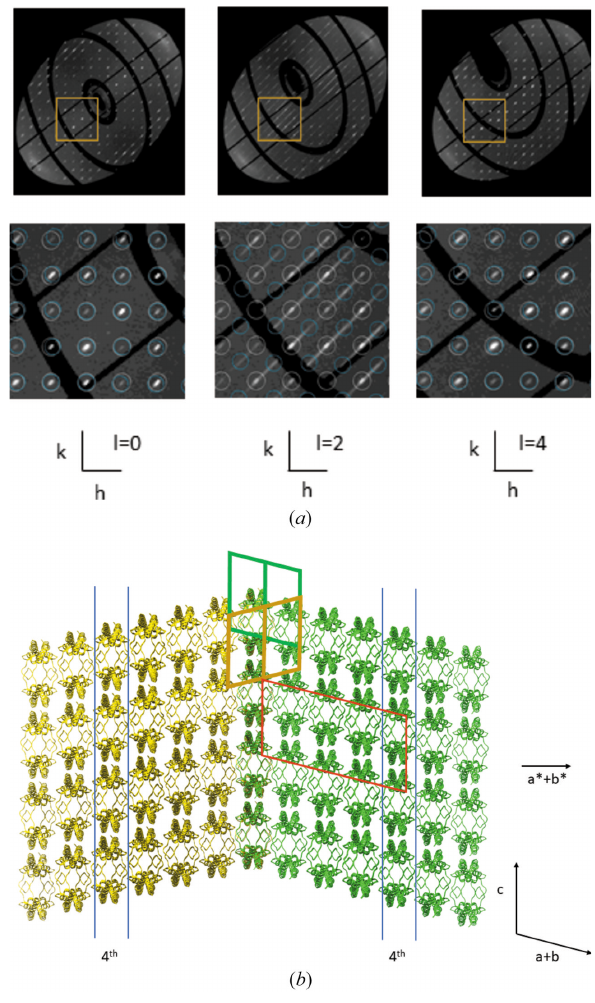
Figure 2 Twinned CD9 EC2 crystal. ( a ) Reciprocal space reconstructions, hk 0, hk 2 and hk 4. The lower panels are zoomed in at the area of the yellow box, where Bragg reflections originating from lattice 1 and 2 are coloured white and cyan, respectively. In slice hk 2, streaks along a* + b* are evident. All slices hk ( l = 4 n ) are ordered and the spots indexed by the two matrices nearly overlap, while in slices hk ( l = 4 n + 2) they have maximum separation. ( b ) Green and gold structures represent the two twin domains in the crystal. The second domain is rotated by 180 � around a* + b* with respect to the first. The twin interface is the plane in the middle with base vectors c and a (cid:0) b for either lattice. In the figure, molecules of the two domains are overlayed on this layer. The 180 � twin rotation applied to domain 1 causes chains A and C of the molecules in domain 1 (green) to superimpose on chains B and D of domain 2 (gold), respectively. Starting from the interface the 4th layers (between the blue lines) in the two domains are the same and form an ordered array. A super cell (red) can be constructed with transformation matrix (1, (cid:0) 1,0/0,0,1/ (cid:0) 2, (cid:0) 2,1) on which the two twin lattices overlap. The consequence is that in reciprocal space reflections of the twin lattices overlap for every l = 4 n